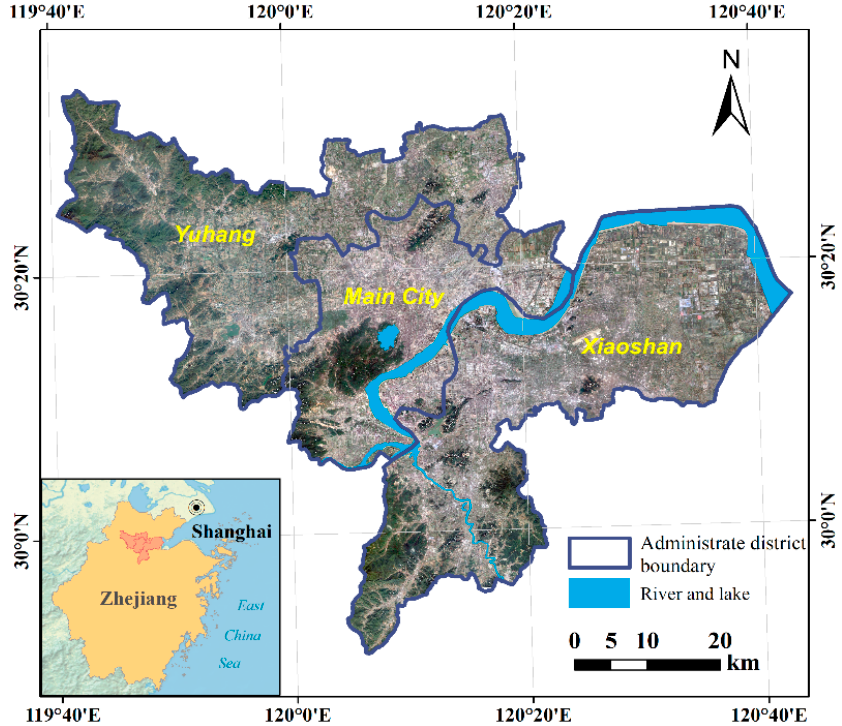
Figure1. Locationofthestudyarea. Figure 1. Location of the study area. The inset map shows the location of Hangzhou in Zhejiang province.